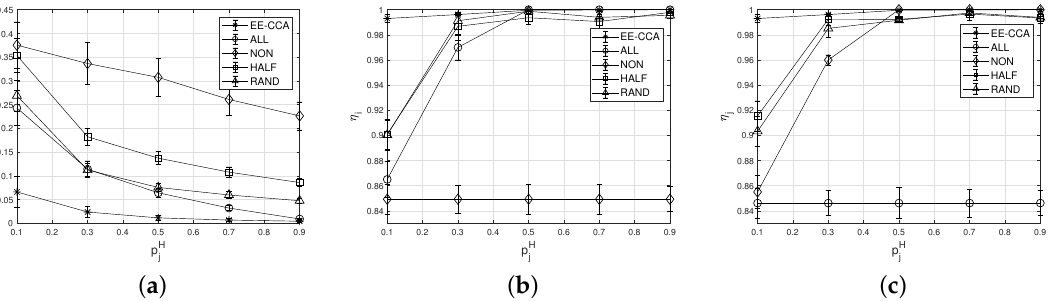
Figure 4. Effect of the harvesting probability. ( a ) average energy outage probability; ( b ) average probability that the task of IoT device i is completed before the deadline; ( c ) average probability that the task of IoT device j is completed before the